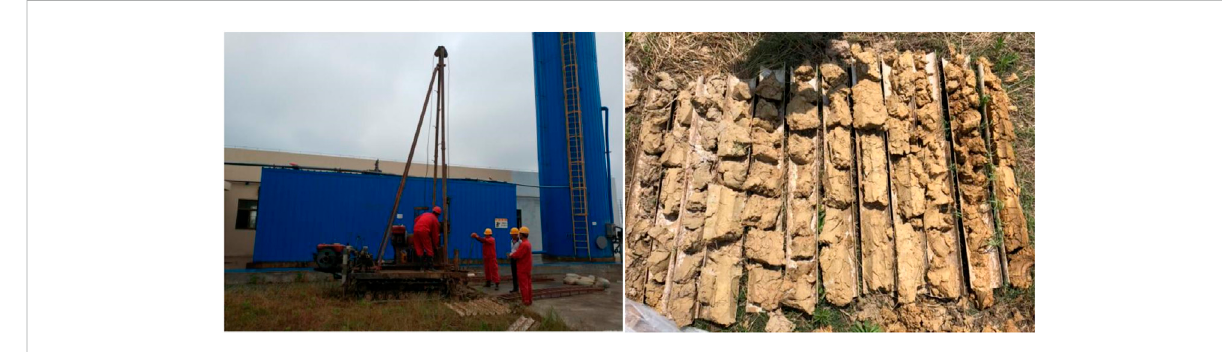
FIGURE 4 Drilling site and soil core sampling process.